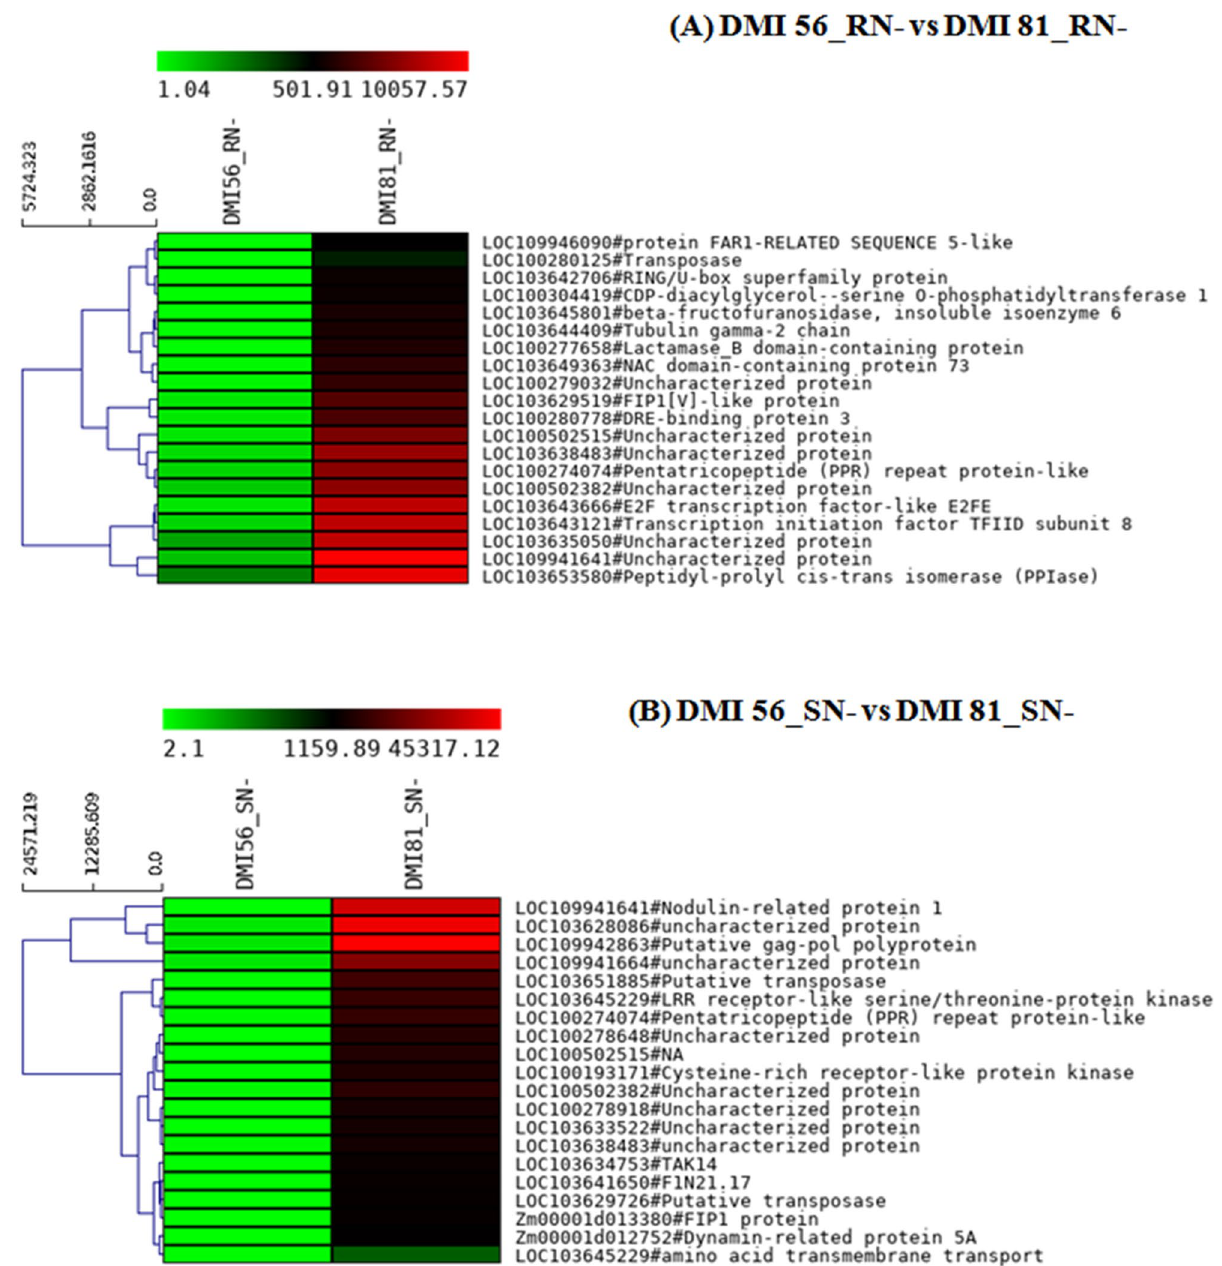
Figure 8. Heat map depicting top 20 down-regulated genes with p value < 0.05 in following combinations ( A ) (DMI 56_RN− vs DMI 81_RN−) and ( B ) DMI 56_SN− vs DMI 81_SN−). In the heat maps, each horizontal line refers to a gene. Relatively up-regulated genes are shown in red colour, whereas down-regulated genes are shown in green